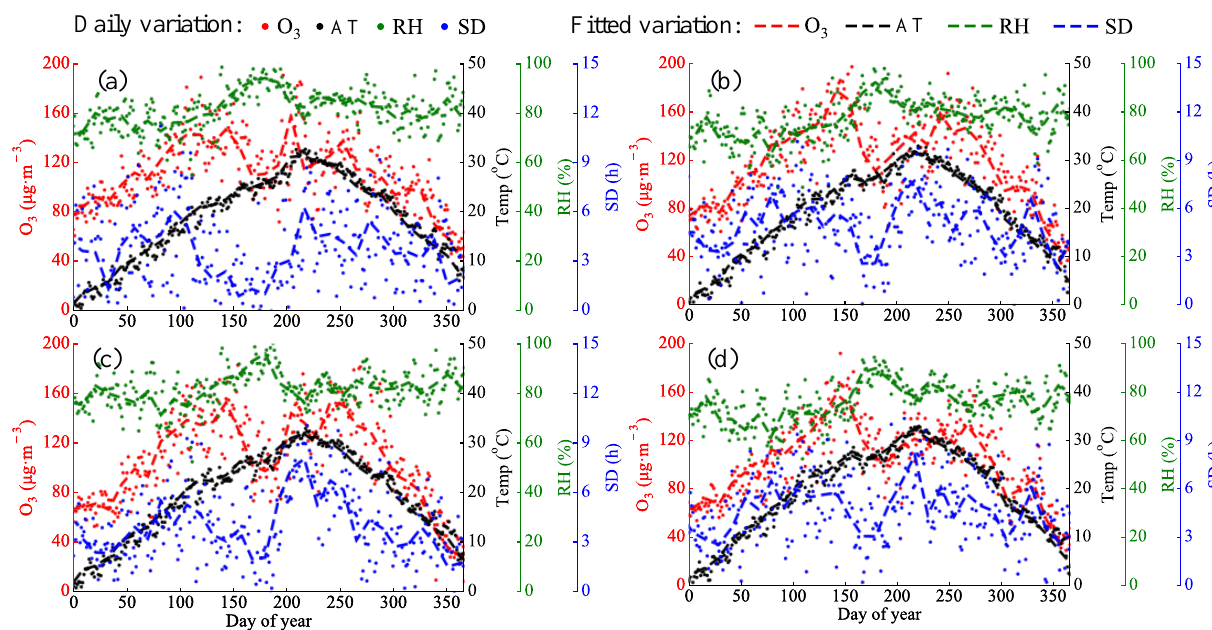
Figure A1. Daily variation of O 3 and meteorological conditions, including air temperature (AT), relative humility (RH), and sunshine duration (SD) over the four capital cities ( a ) Shanghai, ( b ) Nanjing, ( c ) Hangzhou, ( d ) Hefei in the Yangtze River Delta.